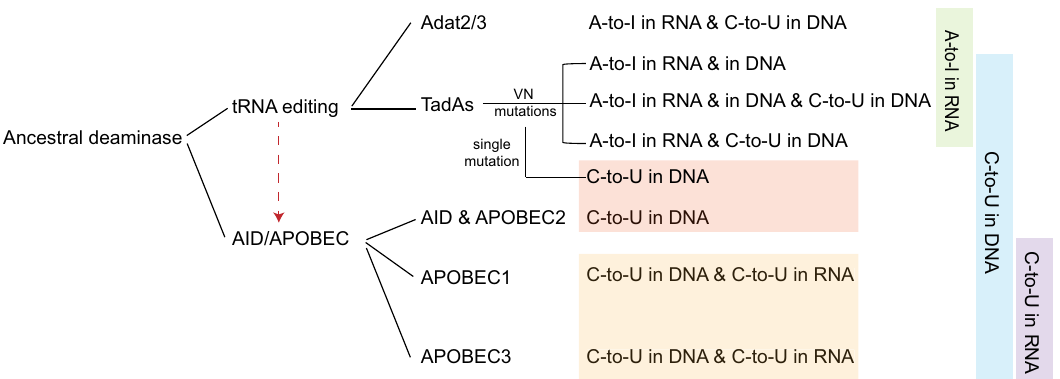
Fig. 5 | Simpli fi ed phylogenetic tree of tRNA-editing deaminases and AID/ APOBEC deaminase family. Substrate speci fi city of different deaminases was displayed in a phylogenetic tree, with TadAs showing all different substrate spe- ci fi cities of engineered orthologs in this study. DNA-speci fi c C-to-U deamination washighlightedinorange,whilebothDNAandRNA-targetableC-to-Udeamination